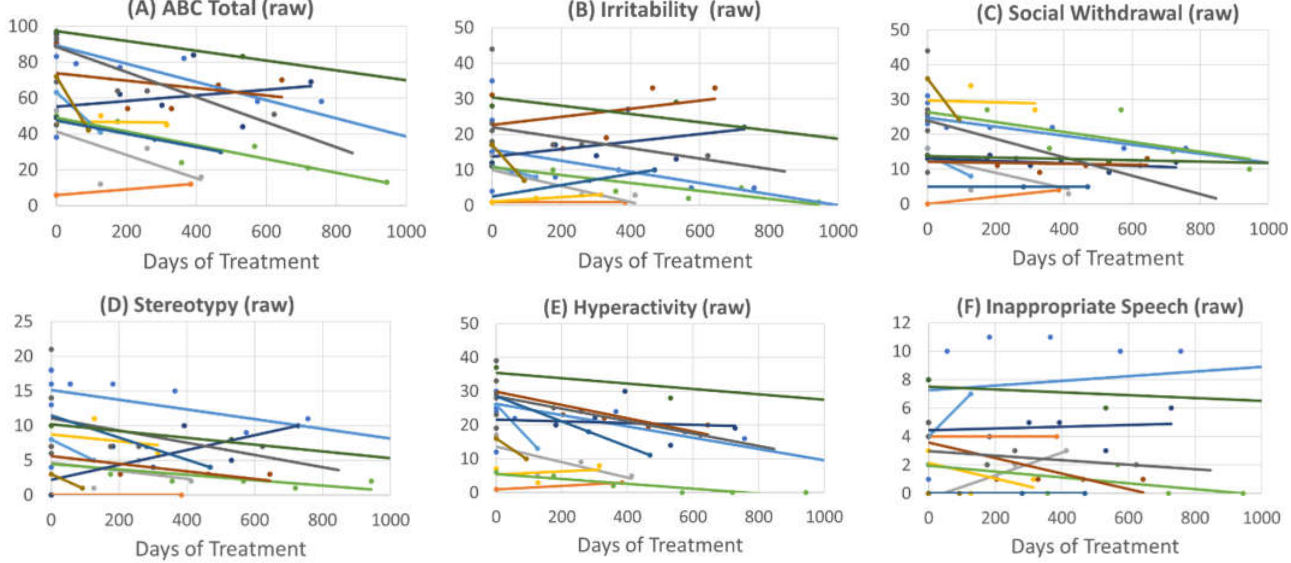
Figure 2. Change in the Aberrant Behavioral Scale raw score over time with initiation of leucovorin for patients with soluble folate binding proteins: ( A ) Total Score, ( B ) Irritability, ( C ) Social With- drawal, ( D ) Stereotypy, ( E ) Hyperactivity and ( F ) Inappropriate Speech. Each color line represents a single patient.